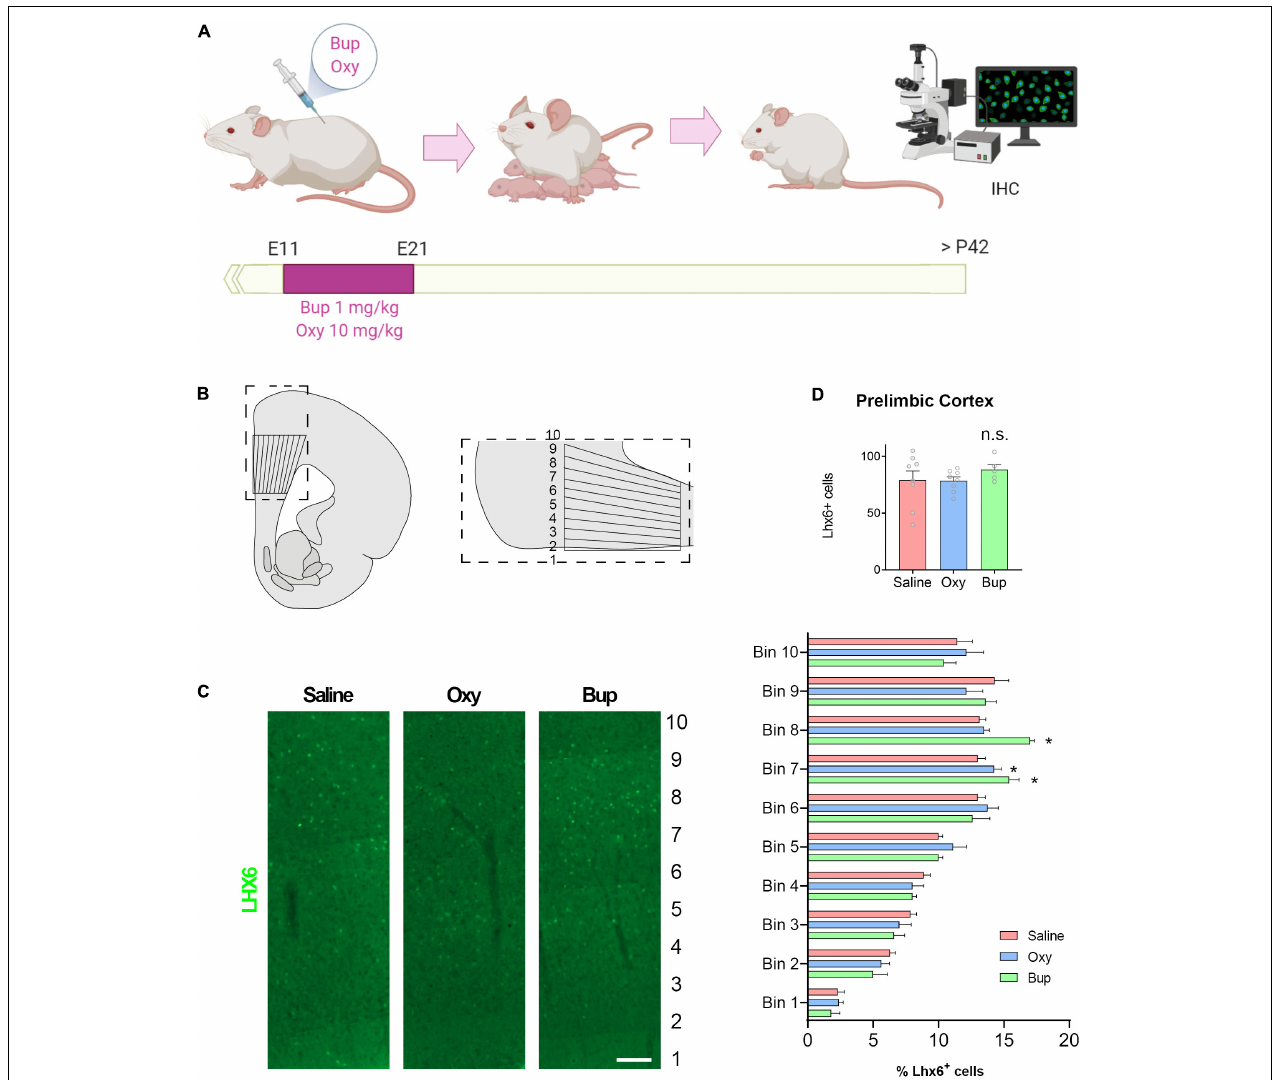
FIGURE 4 | Prenatal buprenorphine alters interneuron migration in the rodent cortex. The experimental design is depicted in (A) . The region of the medial prefrontal cortex analyzed is shown in (B) . Representative images of Lhx6 + cells are shown in (C) . The total number of Lhx6 + cells in the prelimbic region (PrL) of the mPFC is not altered by in utero opioid exposure. The distribution of Lhx6 + cells throughout the PrL is altered by buprenorphine exposure (D) . n = 5-8 rats from 3 litters per group. Scale bar = 100 µ m. * p < 0.05, n.s.,no significant: